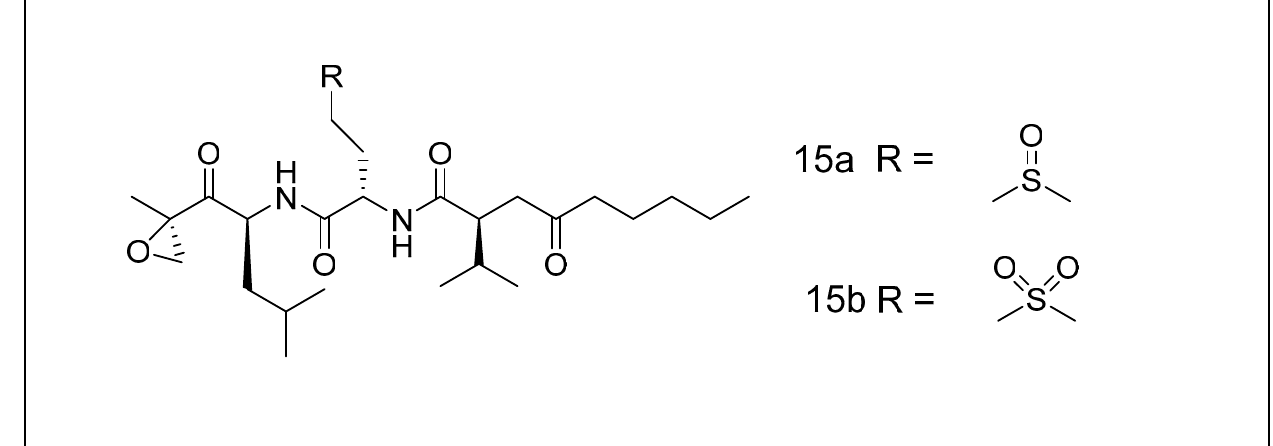
Figure 4. Chemical structures of carmaphycins 15a and 15b .